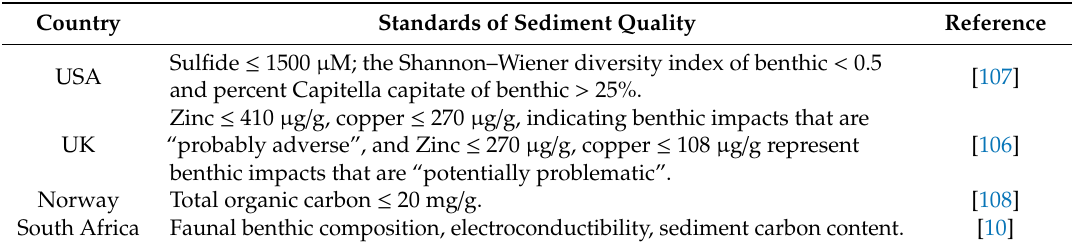
Table 5. List of sediment quality standards of regulatory mixing zone (receiving environment) in di ff erent countries and